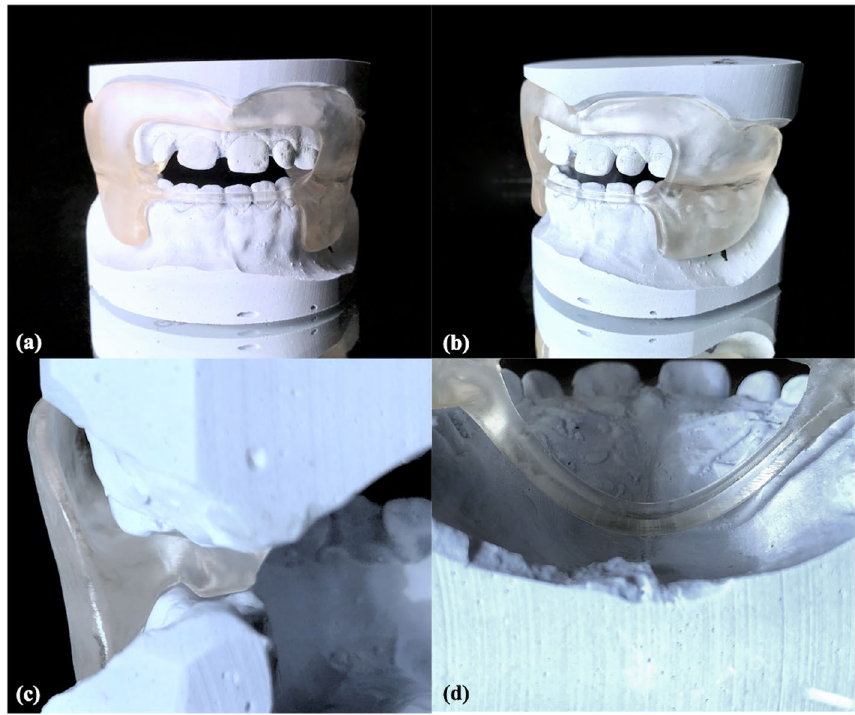
Figure 3. CAD/CAM functional regulator 3 (CAD-FR3) on plaster model. ( a , b ) To ensure maximum periosteal traction, CAD-FR3s were extended to the bottom of the maxillary vestibular fold, which had previously been deepened on the model by 2–3 mm along the alveolar ridge. In the maxilla, the vestibular parts were blocked out up to 3 mm, and the occlusal parts were flat in design to ensure unrestricted maxillary post-development. ( c ) In the mandible, both the vestibular and occlusal parts were designed to fit closely to the bone, to ensure maximum growth inhibition. ( d ) The palatal connectors were constructed 2–4 mm from the palate.